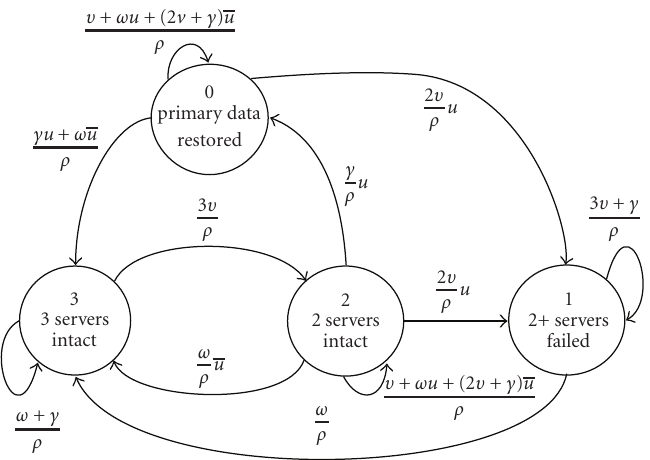
Figure 2: Markov chain model of the database reflecting only the server